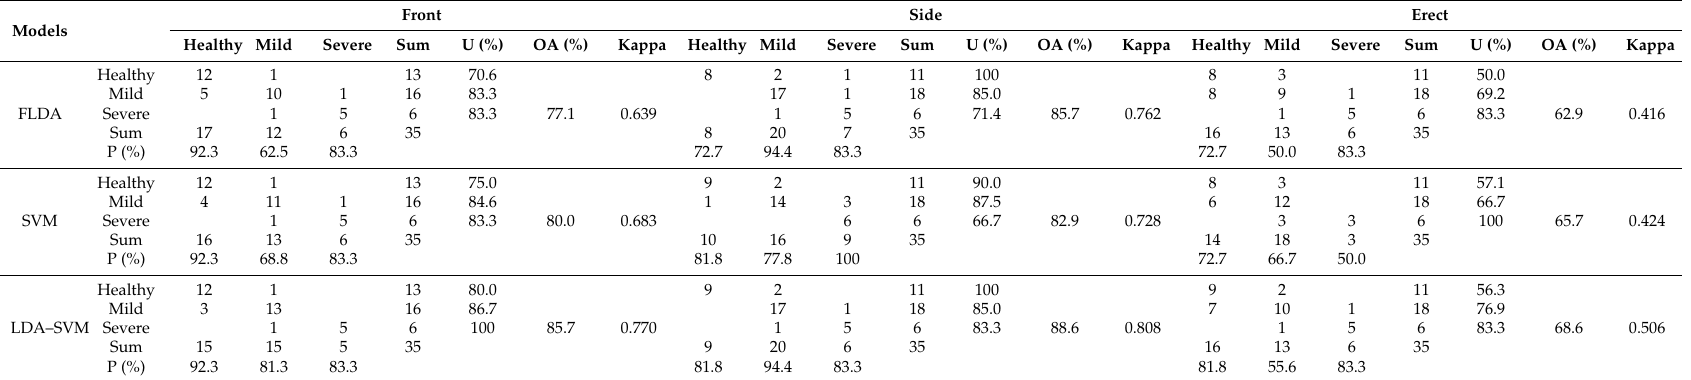
Table 9. Confusion matrix and classification